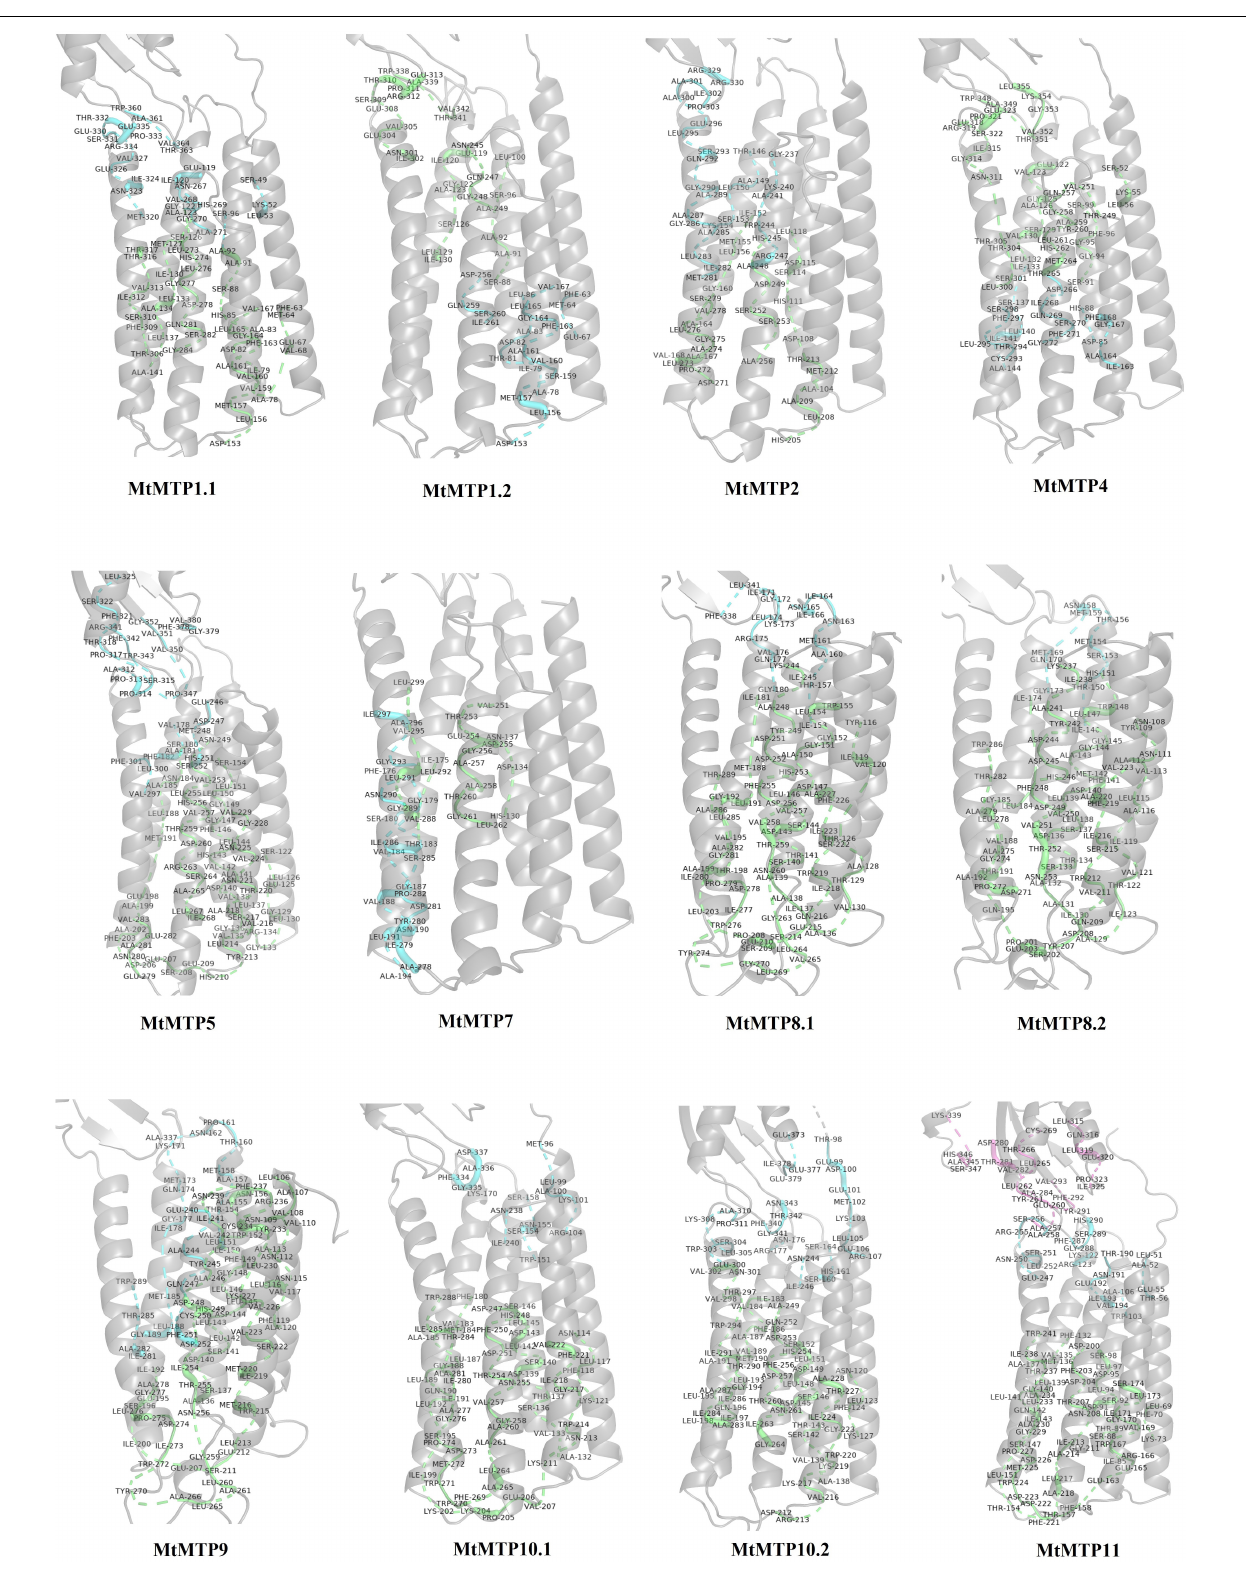
Frontiers in Genetics |